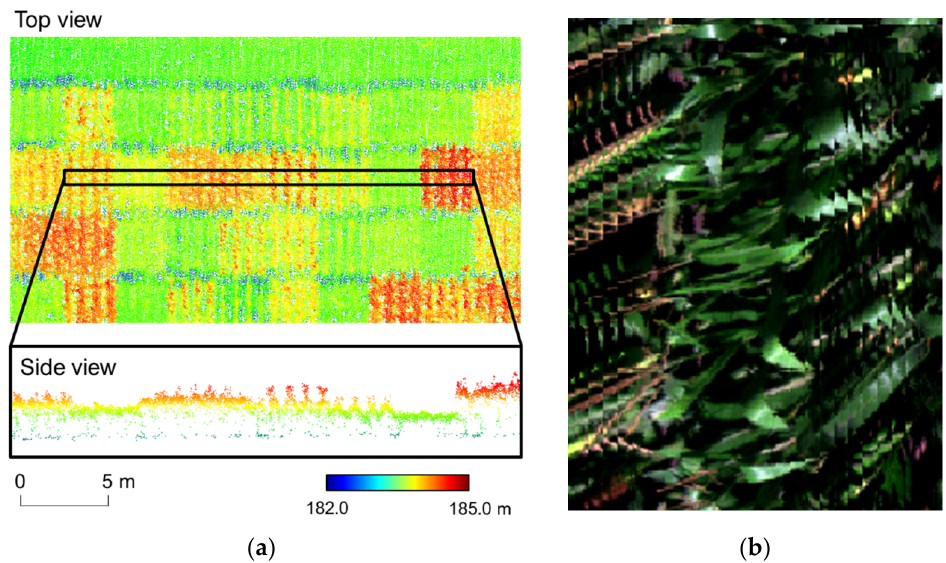
Figure 1. Challenges for orthophoto generation in agricultural fields: ( a ) sample LiDAR point cloud in an agricultural field with four-row plots showing height variation between neighboring plots and ( b ) example of double mapping problem when occlusions resulting from relief displacement are not considered.